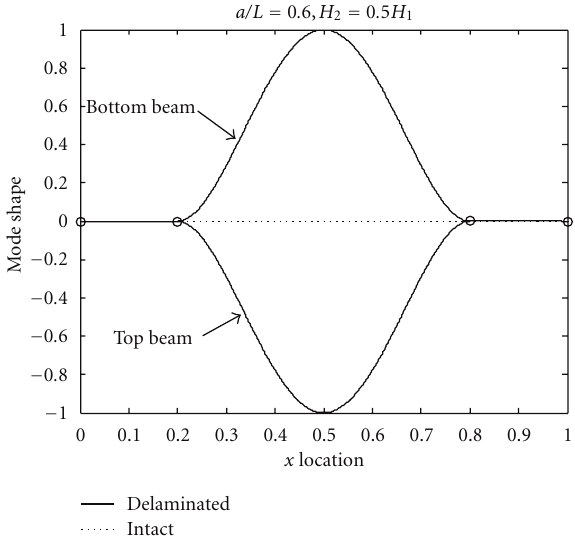
Figure 4: The inadmissible mode: interpenetration of equi-thick- ness top and bottom beams. While mathematically possible, this situation would not be encountered in practical applications; 60% of span, midplane delamination.